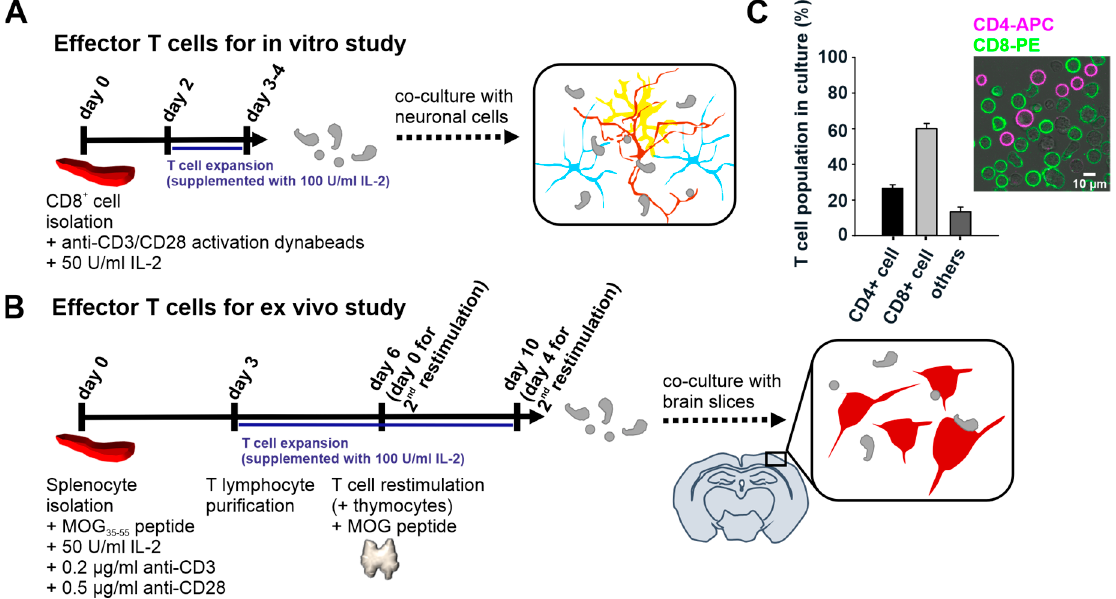
Figure 2. Effector T cell generation for co-culturing with neuronal cells or brain slices. ( A ) Workflow of effector T cell generation for the in vitro study. Naive CD8+ T cells were positively isolated from splenocytes and were activated by anti-CD3/anti-CD28 activation dynabeads. The T cell culture was supplemented with mouse IL-2 protein for further proliferation. The cells were used for co-culture with neuronal cells on day 3 or day 4 culture. ( B ) Workflow of MOG antigen-specific effector T cell generation for the ex vivo study. Naive T cells were cultured in a splenocyte pool that was supplemented with MOG peptide and IL-2 protein to prime T cells with the CNS-specific antigen. After 3 days in culture, the T cells were purified using Ficoll density gradient centrifugation. After 6 days in culture, the T cells were further restimulated with thymocytes supplemented with MOG peptide (second restimulation). Finally, blast cells were developed in culture 2 days after restimulation (day 8). Day 4 T cells (second restimulation) were used for co-culturing with the acute brain slices. ( C ) Quantitative analysis of the MOG-specific T cell population generated from WT mice in culture from ( B ). A confocal image of MOG-specific lymphocytes stained with anti-CD4-APC and anti-CD8-PE antibodies. Cell counting analysis was conducted from three independent preparations (data presented as mean ± SEM; N = 3; n = 6388).